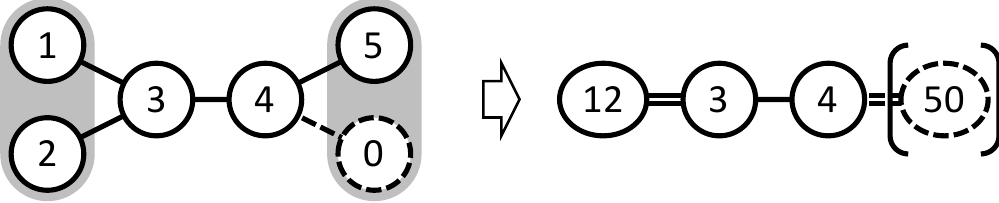
Figure 10 . The b D 5 Dynkin diagram and the B 3 Dynkin diagram obtained by the Z 2 folding. In the three-dimensional subspace corresponding to brane configurations without deformations of FI parameters, only the combined transformations s These transformations correspond to the trivial HW transitions for 5-branes of the same